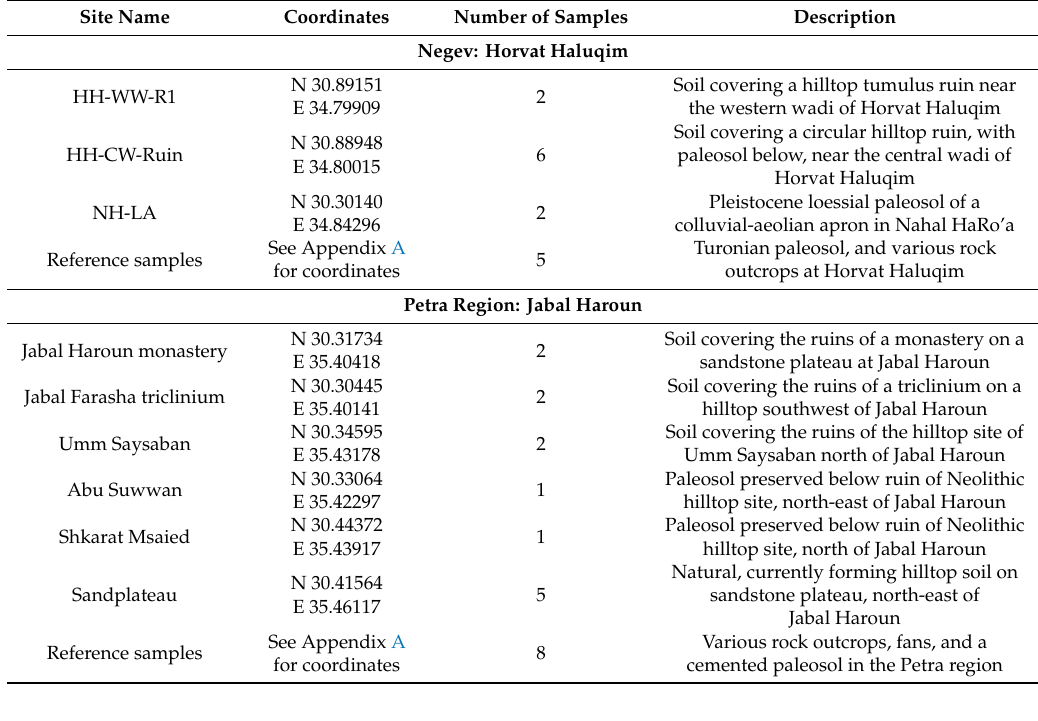
Table 1. List of sampled soil profiles and of samples from outcrops as references of potential local sediment sources. For detailed descriptions of the sampled profiles, see Appendix A.